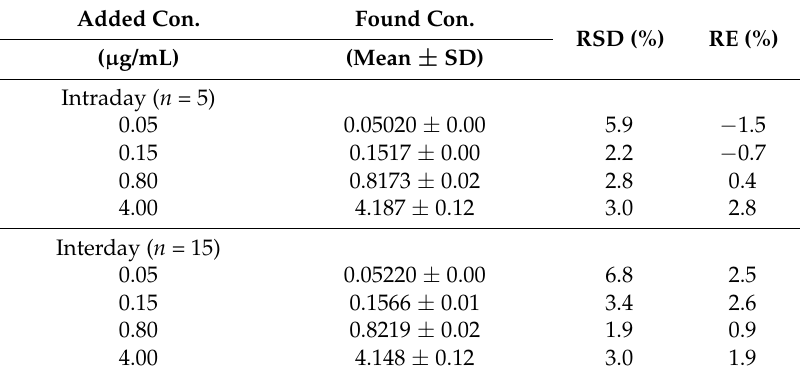
Table 2. Intraday and interday precision (% RSD) and accuracy (% RE) of the assay for CMME in dog plasma. Added Con. Found Con.